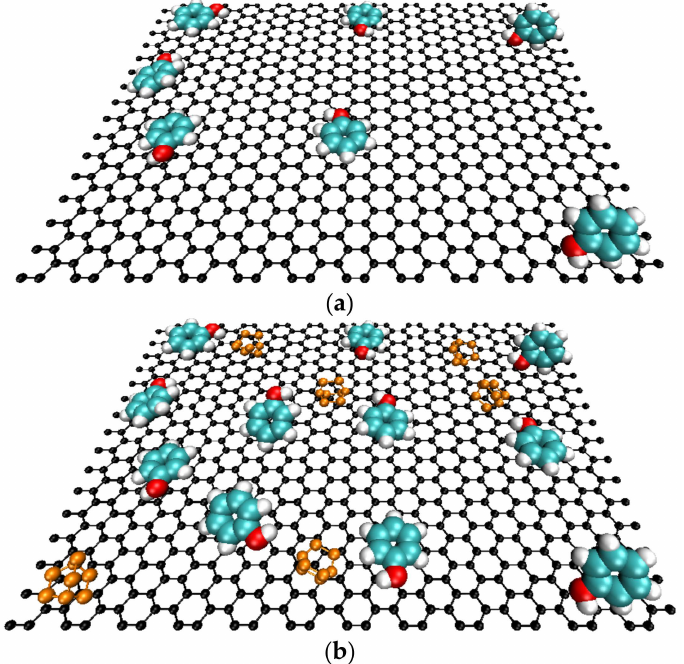
Figure 5. Schematic representation of the phenol adsorption at the activated carbon surface ( a ) pristine samples, ( b ) TEDA modified